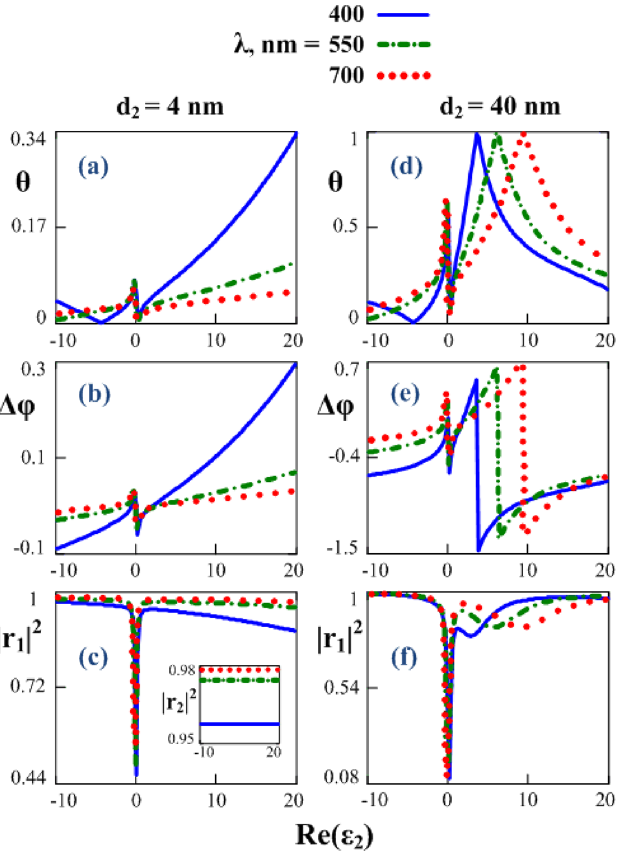
Fig. 11. The same data as in Figure 7 but for TM polarization of the incident wave and incidence angle c = p /5. Parameter e 0 2 is used as the abscissa axis for all the graphs.